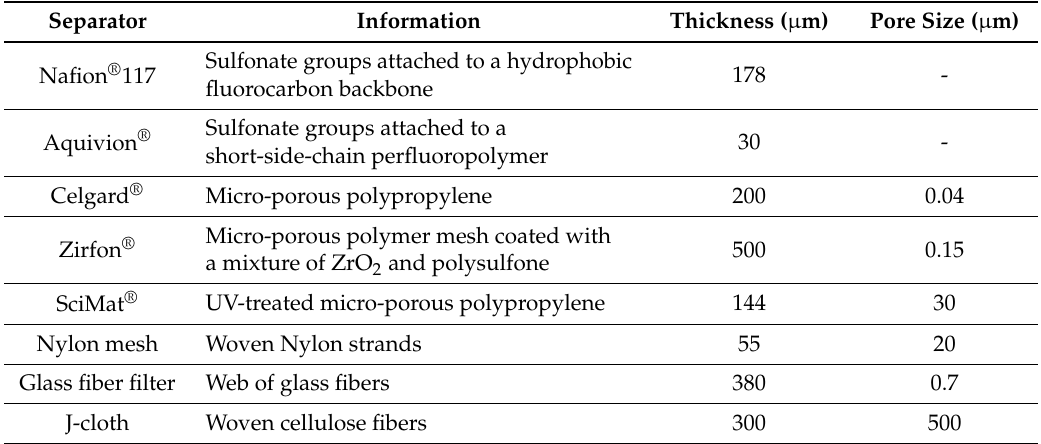
178 - 30 - 500 0.15